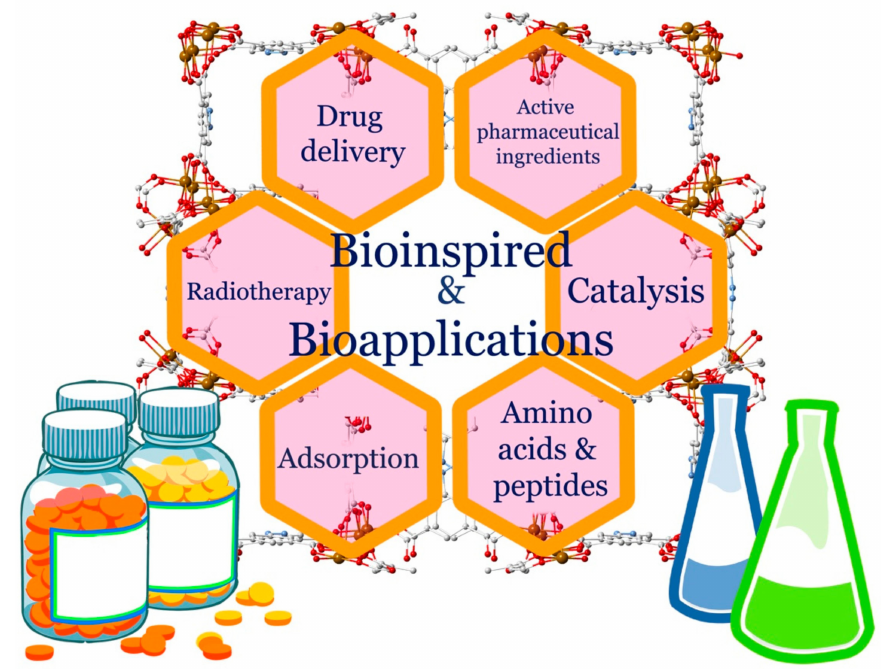
Figure 1. Schematic representation of bioapplications and biomaterials or active species used in the synthesis of metal-organic frameworks